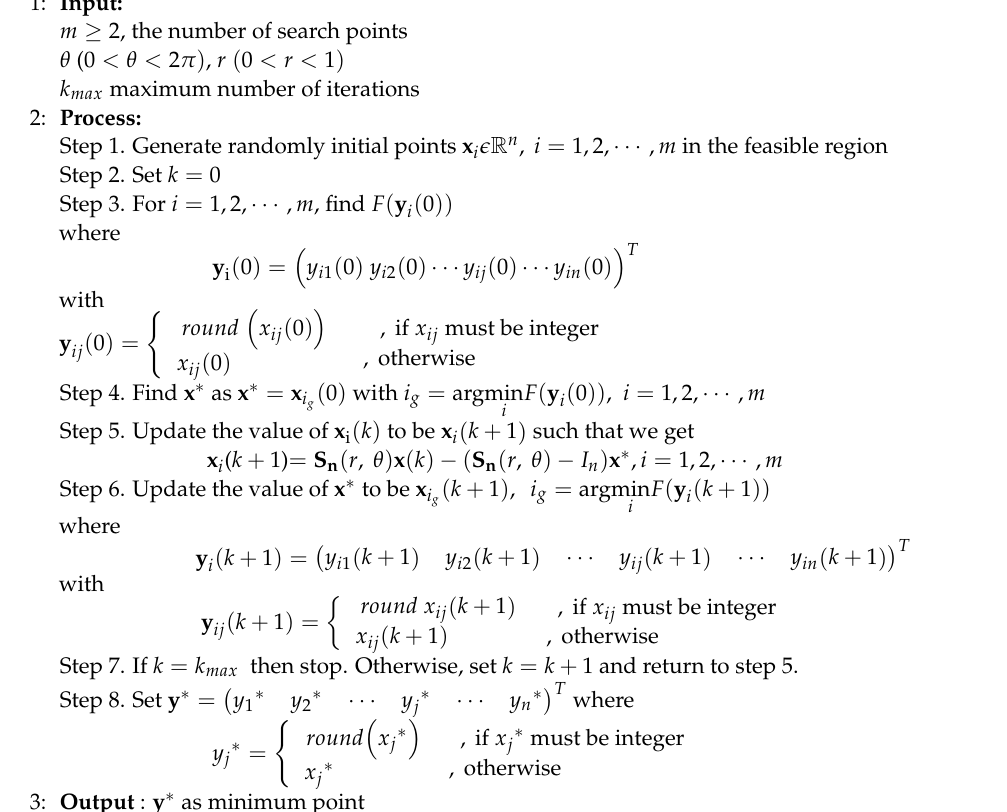
Algorithm 2. Spiral Optimization Algorithm for Solving the MINLP